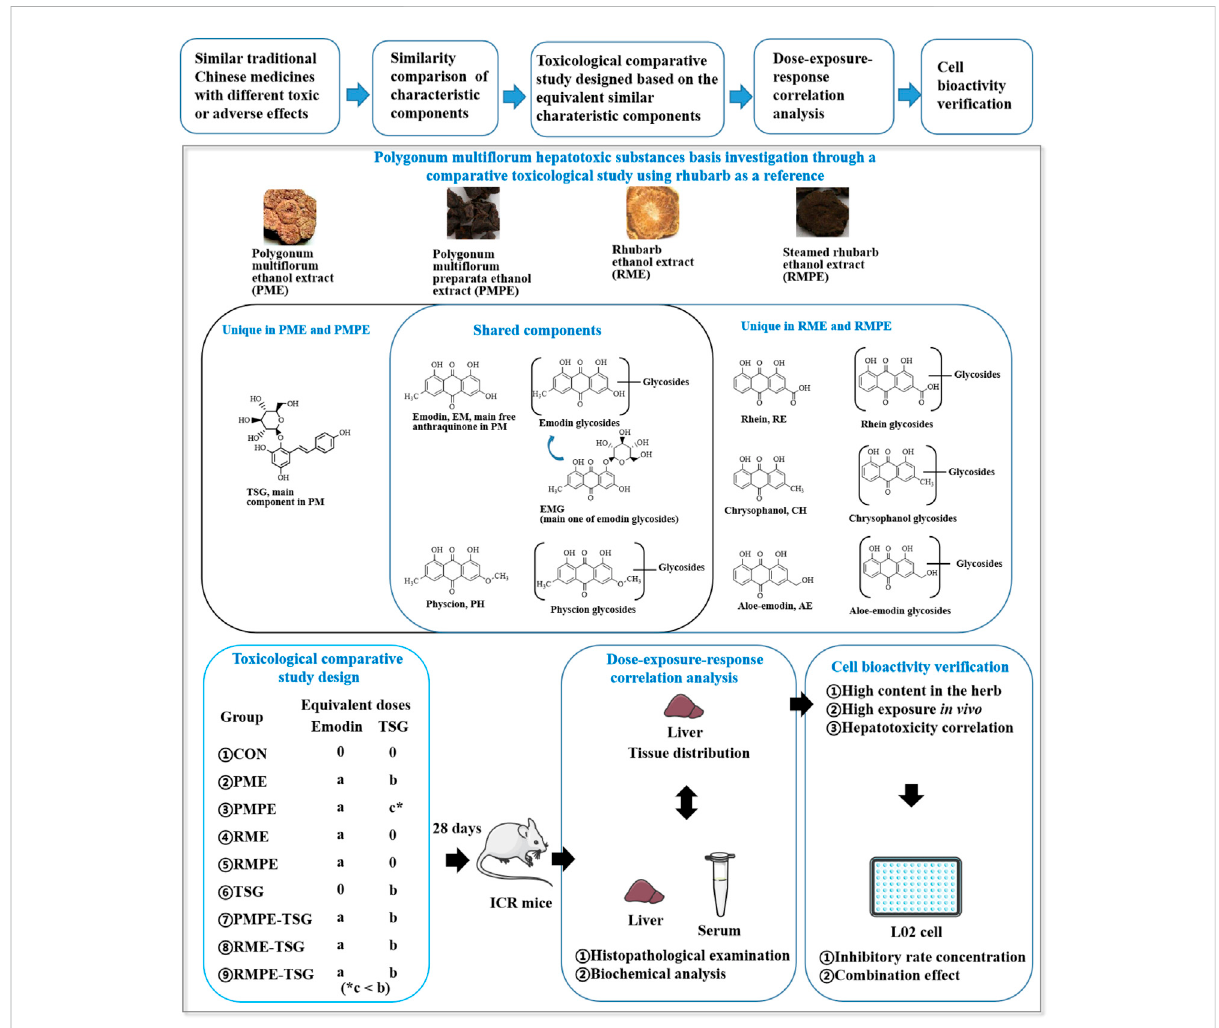
FIGURE 1 Scheme for the hepatotoxic substances basis study of PM using rhubarb as a reference based on their characteristic components ’ similarity. ‘ a, b,c ’ representsthedoselevel ofemodinorTSG.Eachexperimentalgroup wasdesignedto have anequivalentemodindoseof ‘ a ’ except for theTSG group, and an equivalent TSG dose of ‘ b ’ except for the PMPE (with TSG dose of ‘ c ’ ), RME and RMPE groups. In this PM hepatotoxicity study, ‘ a ’ was 29 mg/kg, ‘ b ’ was 1,345 mg/kg, ‘ c ’ was 346